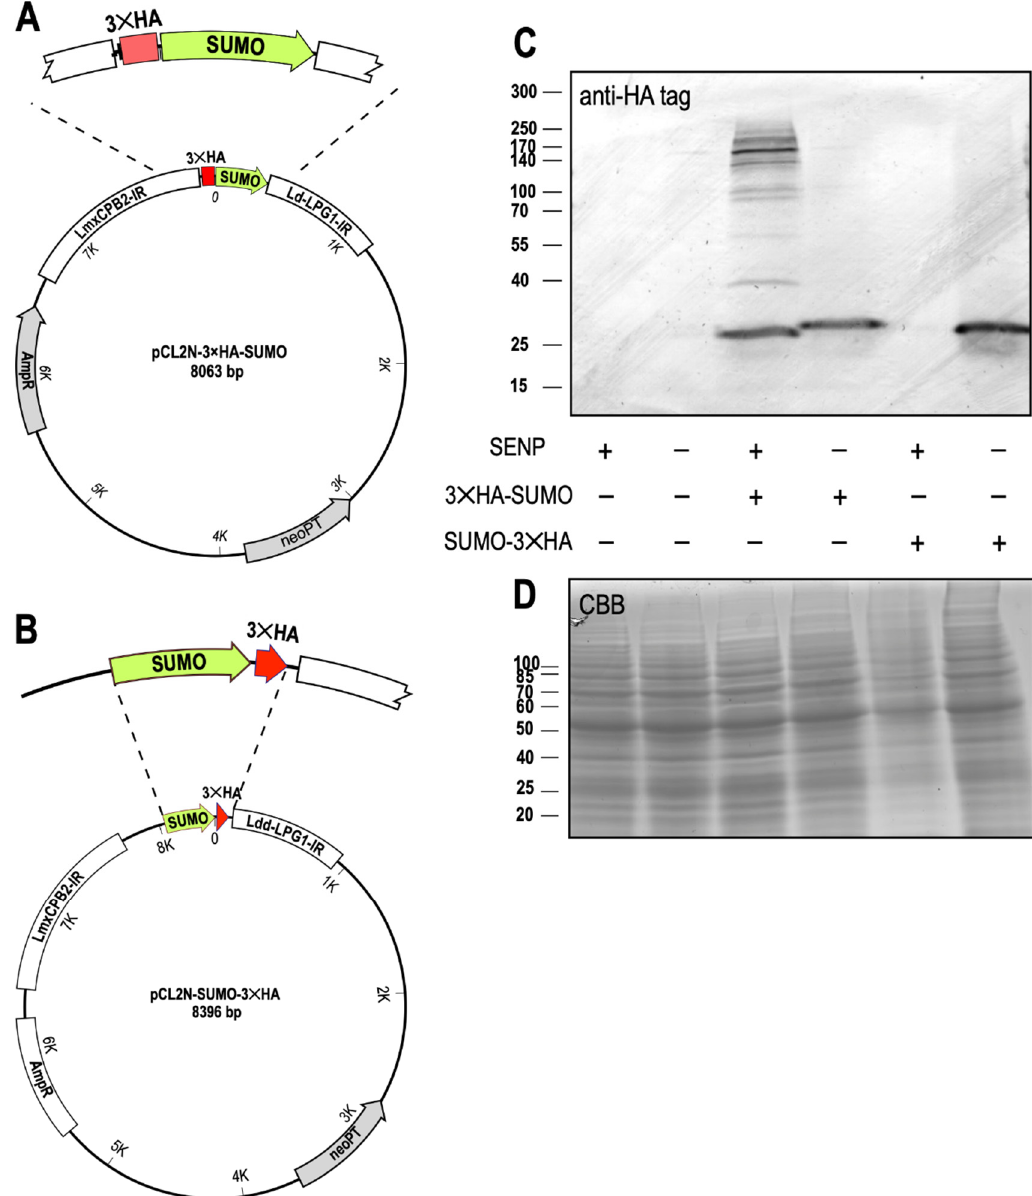
Figure 4. SUMO processing by SENP. ( A ) Schematic drawing of pCL2N-3×HA-SUMO, a plasmid for ectopic expression of SUMO with an N-terminal triple HA tag. ( B ) Schematic drawing of pCL2N-SUMO-3×HA, a plasmid for ectopic expression of SUMO with a C-terminal triple HA tag. ( C ) Western blot of L. donovani wild type or SENP − / − null mutants, expressing 3×HA-SUMO or SUMO-3×HA, probed with anti-HA tag antibodies. n = 2. ( D ) Coomassie brilliant blue (CBB) staining of replicate SDS-PAGE gel, serving as a loading control. The positions and masses of protein size markers are indicated on the left. Original Western blot and gel images can be seen in Figure S1.